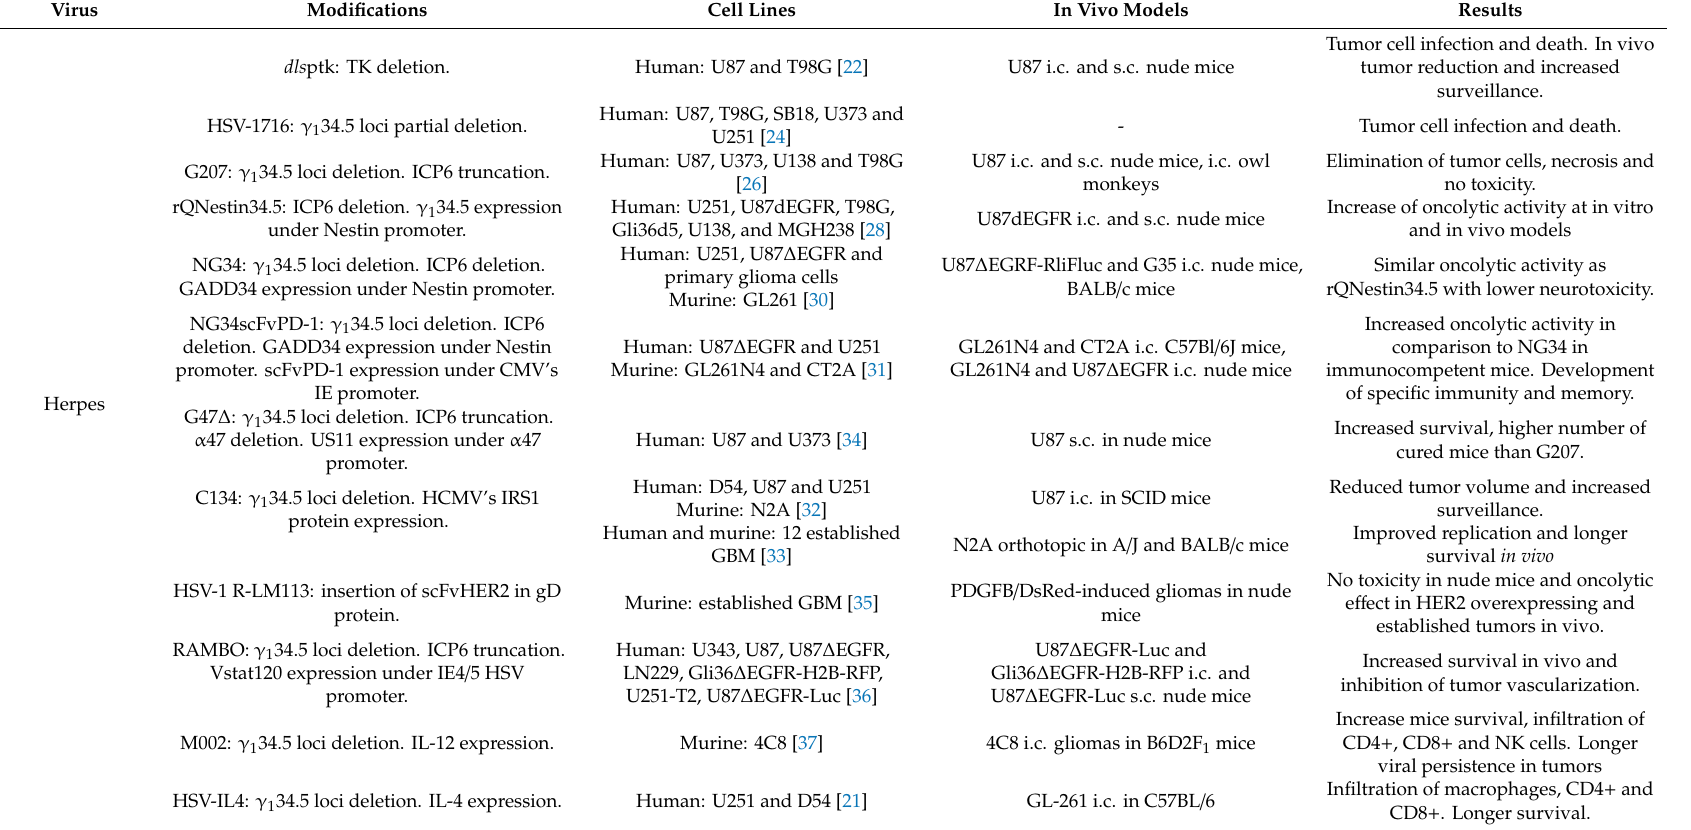
Table 1. Preclinical studies of DNA viruses in glioma